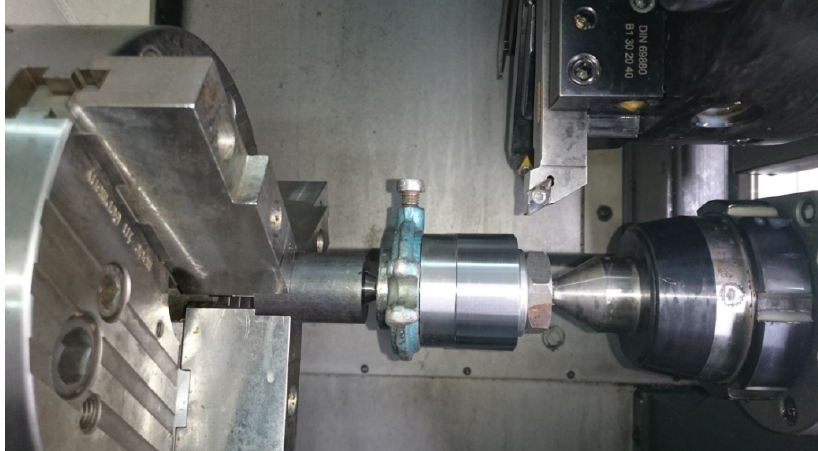
Figure 1. Workpiece holding system used to determine the minimum chip thickness during turning.